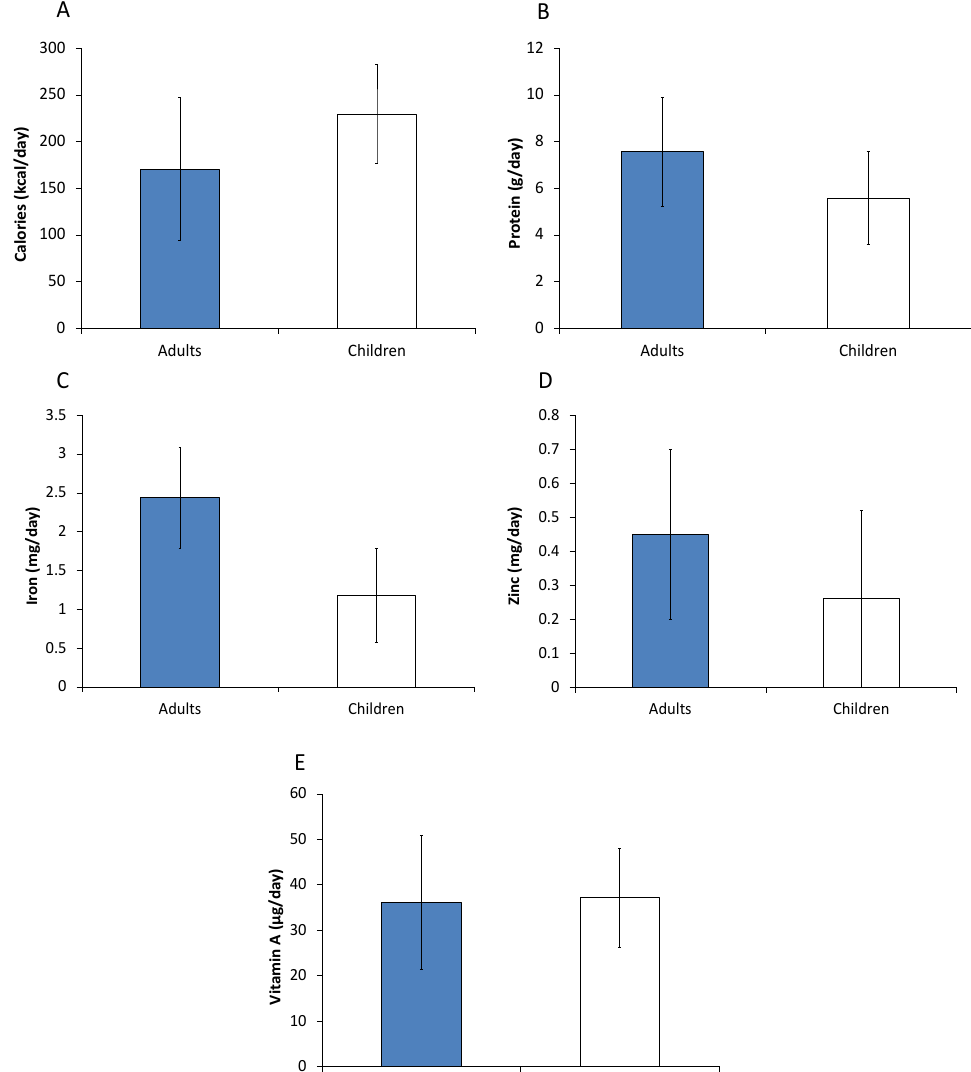
This is a welcome finding, as it implies that poor people benefit over-proportionally from access to modern retailers.